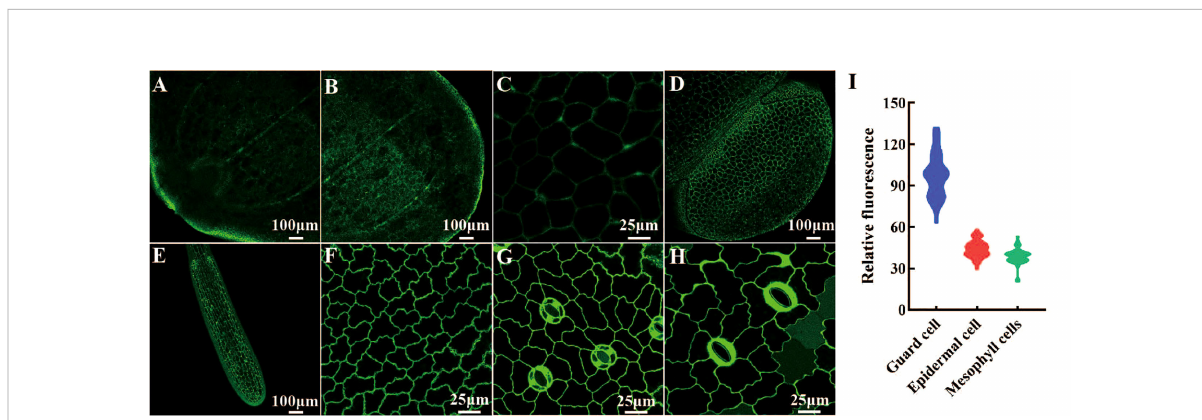
FIGURE 4 Histological localization of LpSUT2. The pCambia2301:proLpSUT2:eGFP transgenic duckweed expressing eGFP is generated and eGFP fl uorescence protein is detected in all tissue cells of transgenic duckweed fronds, including veins (A-B) , parenchyma cells (C) , mature fronds and young fronds (D) , root cells (E) , epidermal cells (F) , and guard cells (G-H) . (I) The relative fl uorescence intensity of eGFP in different cells (at least 40 cells respectively) with a laser scanning confocal microscope. Scale bars: 100 m m in (A, B, D, E) ; 25 µm in (C, F, G, H) . LpSUT2, Sucrose transporter 2 of L. punctata ; eGFP, Enhanced green fl uorescent